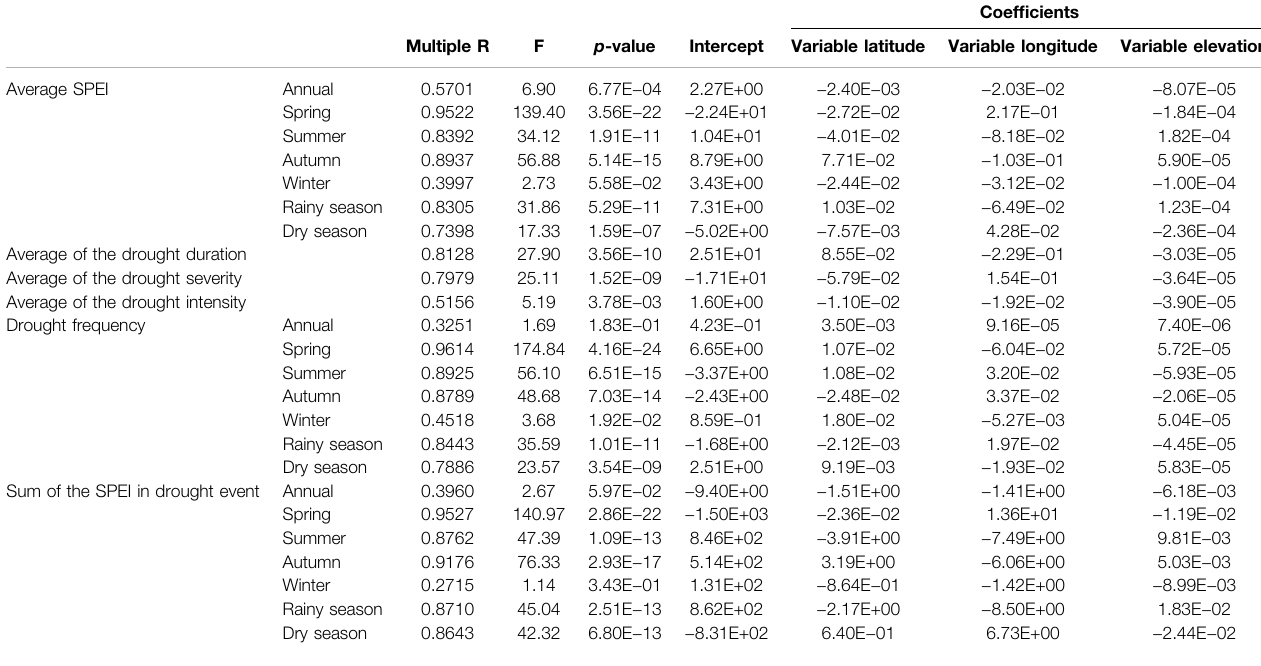
TABLE 6 | Multiple linear regression analysis of average SPEI and drought characteristics with longitude and latitude and